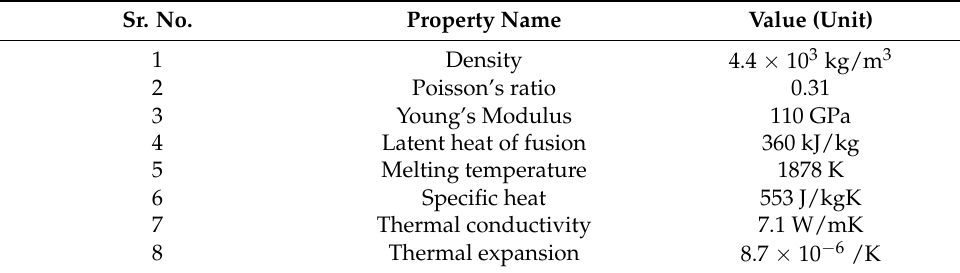
Table 2. Thermo-physical properties of Ti6Al4V (data from Ref. [69]). Sr. No.